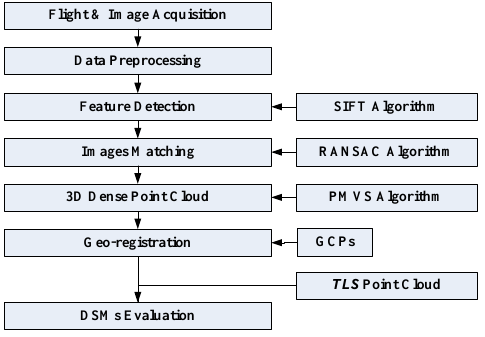
Fig.3 Workflow for the processing of UAV